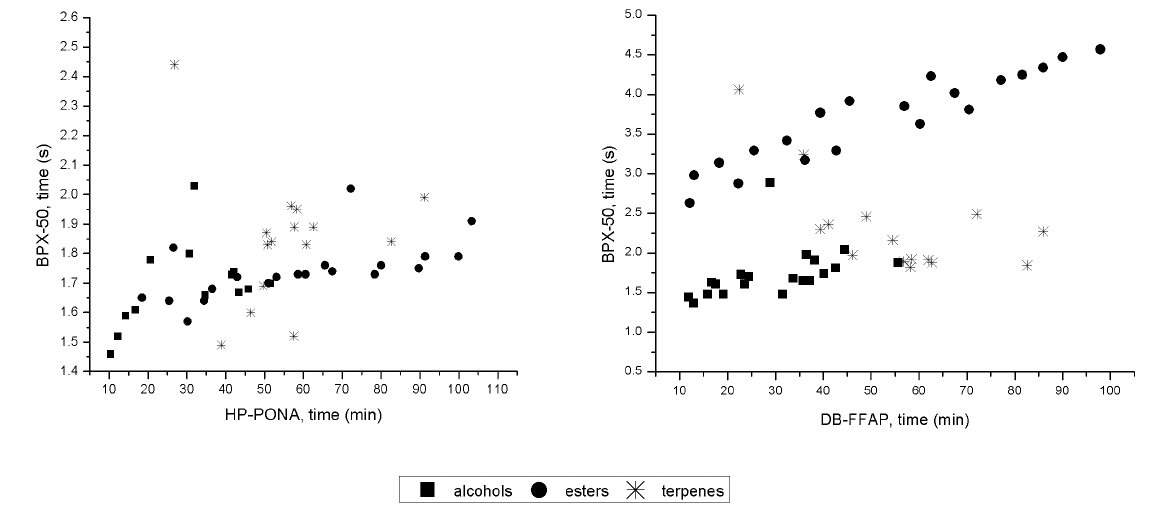
Figure 2: Distribution of main compound classes in Sorbus domestica beverage.